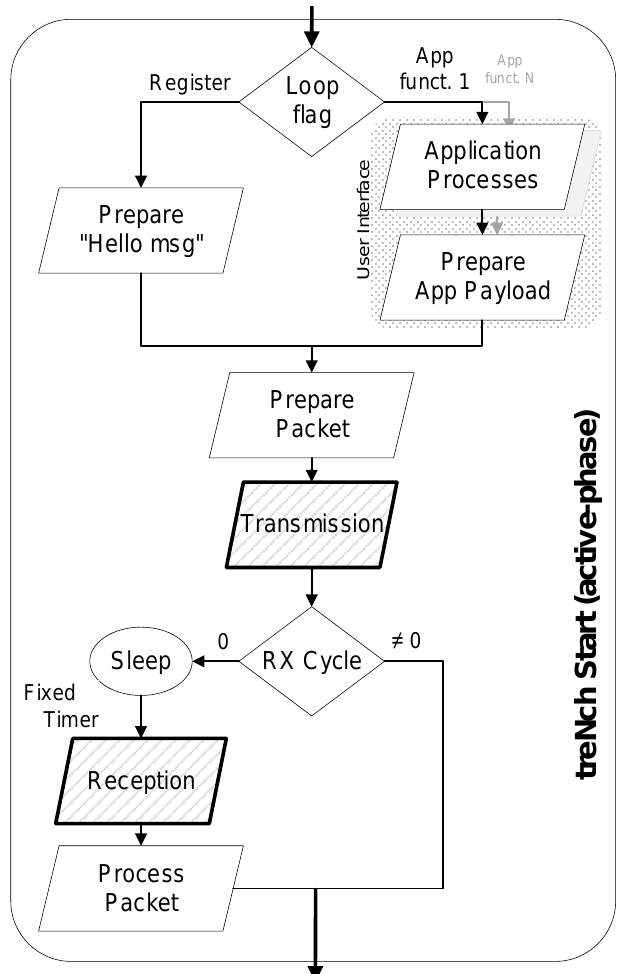
Figure 4. treNch node active phase workflow. Executed cyclically before and after a low power state